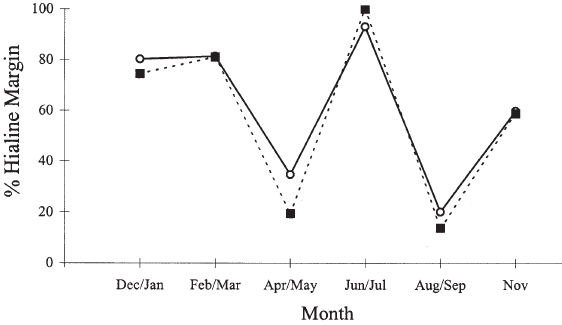
F IG . 6. – Seasonal variation of percentage of hialine margin on dorsal spine and vertebrae of Balistes capriscus , captured off São Paulo.